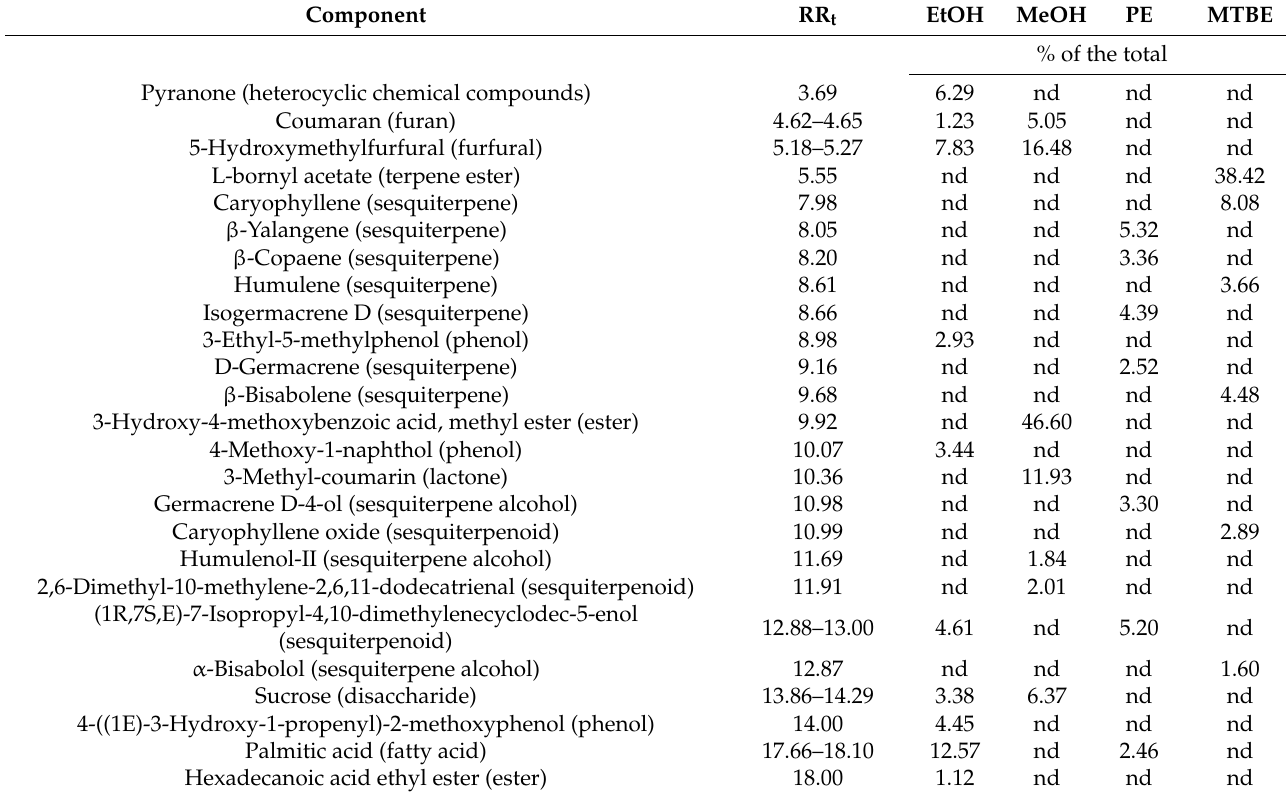
Table 2. Phytochemical composition of different extracts produced from Centaurea scabiosa L.